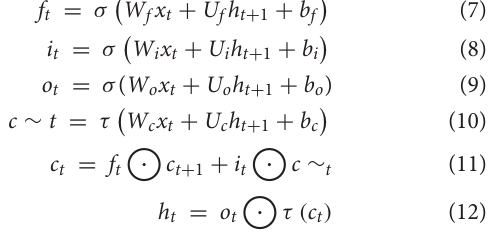
LSTM to learn data’s past and future context (2). The following formulas are used to determine the forward and reverse